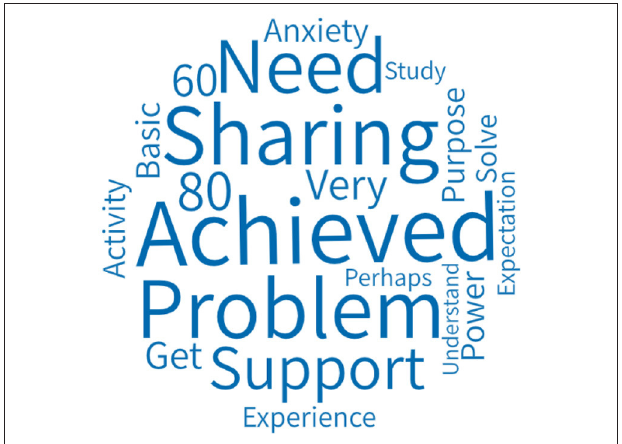
FIGURE 4 | Goal achievement evaluation of